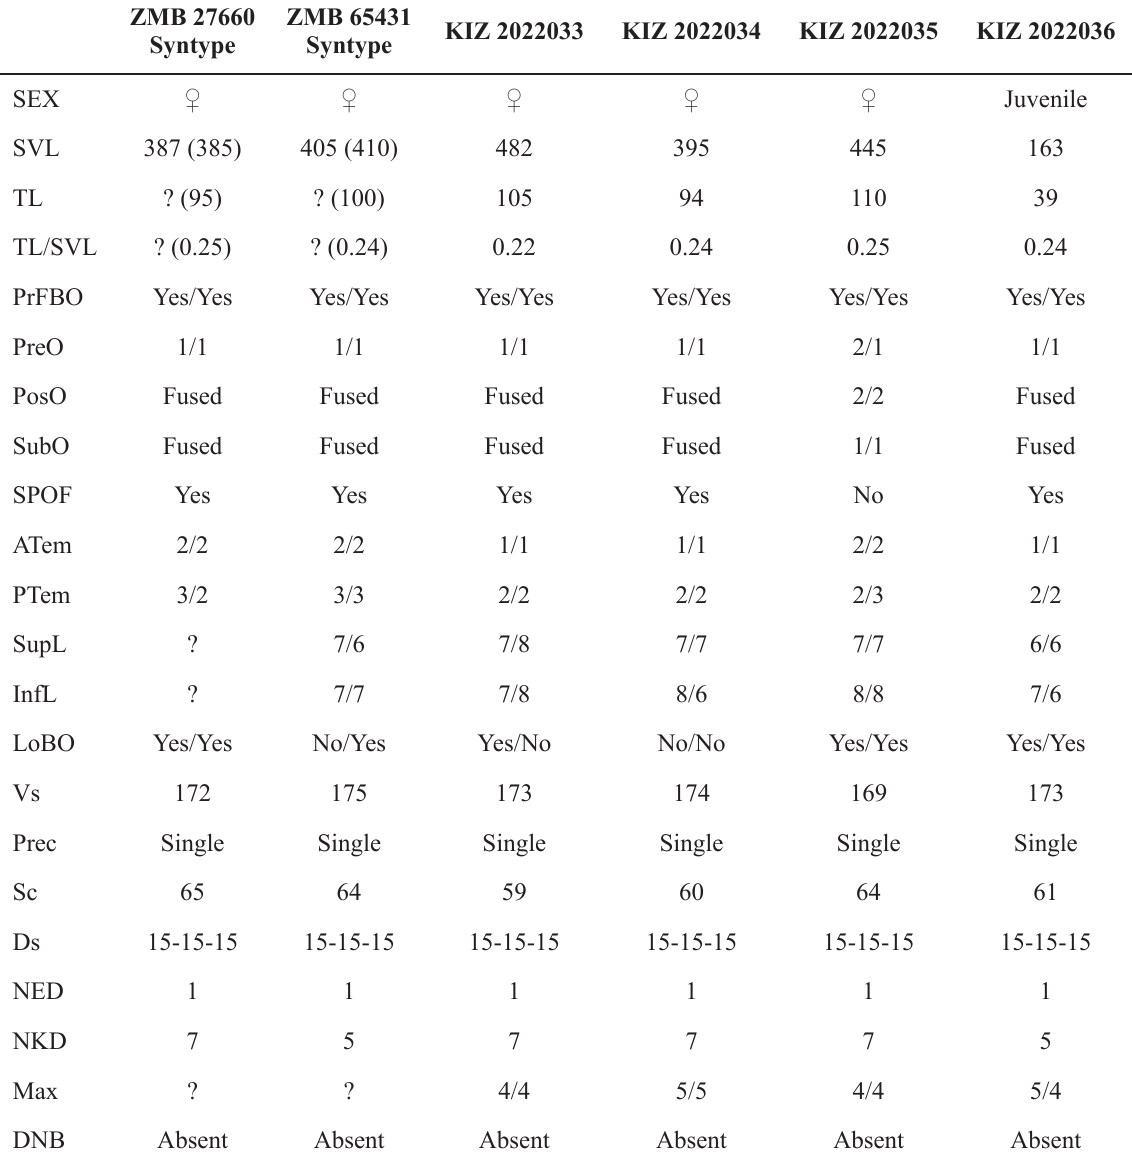
Table 3. Morphological characters of Pareas yunnanensis (Vogt, 1922). For abbreviations, see Material and methods section. Measurements in mm, paired meristic characters given as left/right, “?” = not available, data in parentheses from Vogt